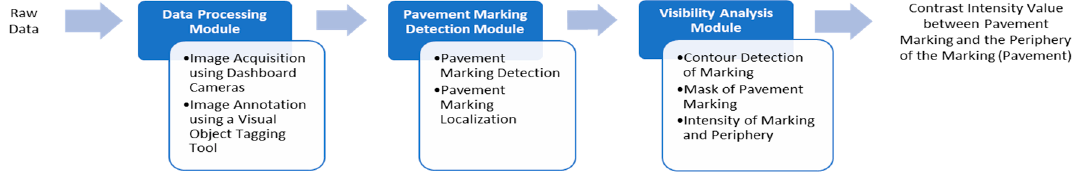
Figure 1. Overview of the Framework for Condition Analysis of Pavement Markings.